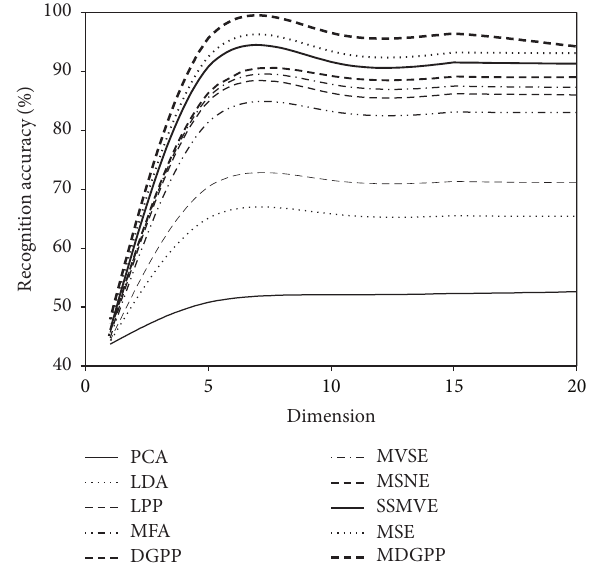
Figure 6: Recognition accuracy versus reduced dimension on the JAFFE database.